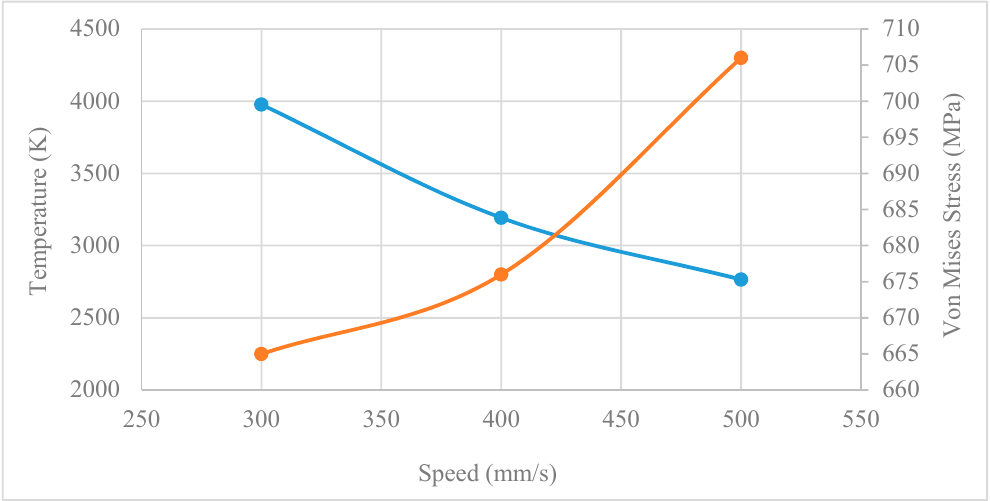
Figure 24. Scanning speed vs. temperature & stress.